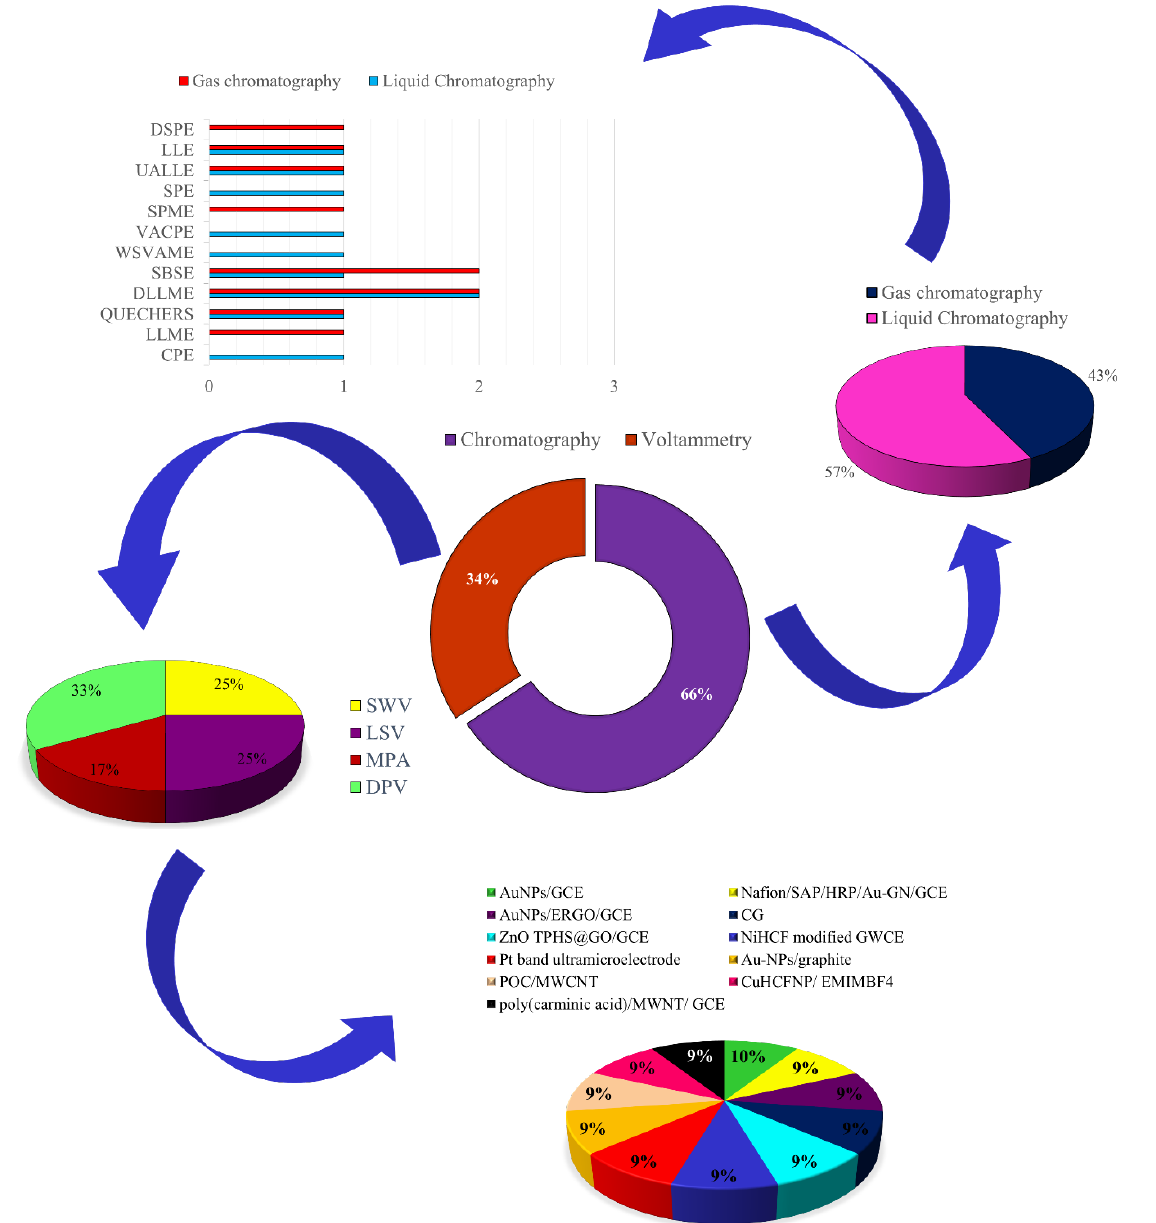
Figure 2. The number of scientific studies published that performed the synthetic phenolic antioxi- dant analysis using chromatographic detection and respective extraction steps and electrochemical techniques and respective working electrodes, from scientific databases in ScienceDirect ® in the years 2011 to 2022. Legend: dispersive solid-phase extraction (DSPE), liquid–liquid extraction (LLE), ultrasonic-assisted liquid–liquid microextraction (UALLME), solid-phase extraction (SPE), solid- phase microextraction (SPME), vortex-assisted cloud-point extraction (VACPE), water-contained surfactant-based vortex-Assisted microextraction (WSVAME), stir bar sorptive extraction (SBSE), dispersive liquid–liquid microextraction (DLLME), quick, easy, cheap, effective, rugged, and safe extraction (QuECHERS), liquid–liquid microextraction (LLME), cloud-point extraction (CPE), square wave voltammetry (SWV), linear scan voltammetry (LSV), multiple-pulse amperometry (MPA), differential pulse voltammetry (DPV). Acronyms in the figure below and to the right are indications of different chemically modified